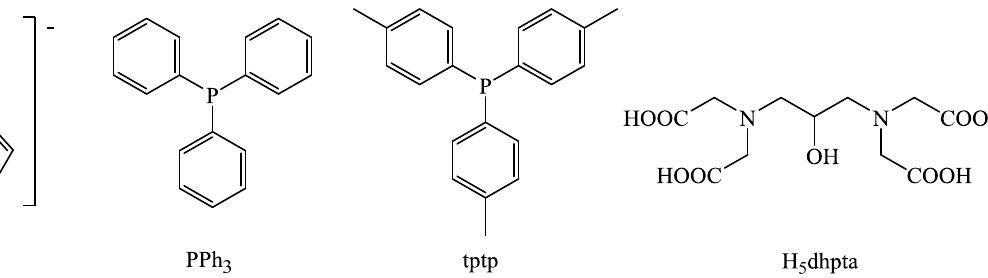
Figure 12. The syntax formula of the co–ligands: Tp − = hydrotrispyrazolylborate; PPh 3 = tri- phenylphosphine; tptp = tri(p–tolyl)phosphine and H 5 dhpta = 1,3–diamino–2–hydroxypropane– N,N,N ′ ,N ′–tetraacetic acid.